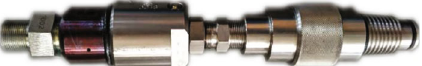
Figure 11: Schematic diagram of ultra-high-pressure rotating water tail.